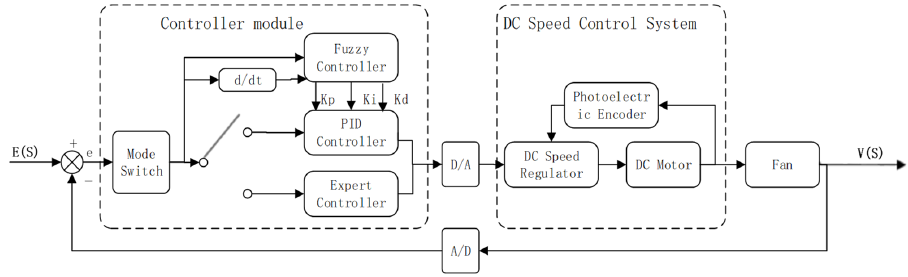
Figure 3. Schematic diagram of the wind velocity measurement and control system.